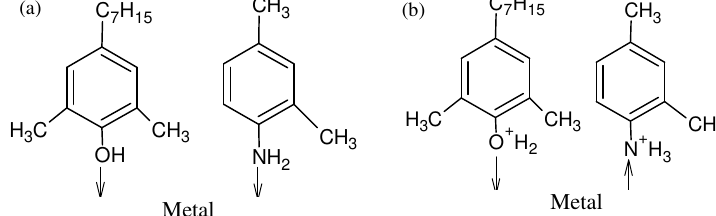
Figure 9. Adsorption model for the binary inhibitor on the metal surface (a) Unprotonated DMA and unprotonated NPH (b) Protonated DMA and protonated NPH